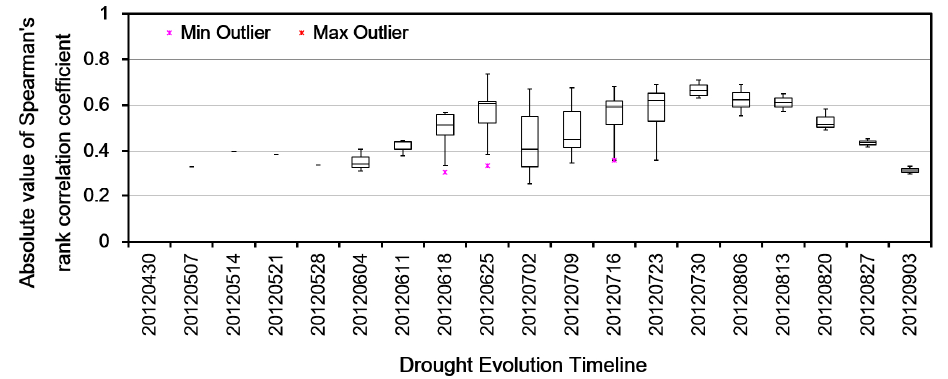
Figure 11. Box plots of correlations between YAI and VCI from the beginning of drought to the end in twelve states in the Midwest. Spearman’s correlation coefficients were considered only at significant level of 5%.